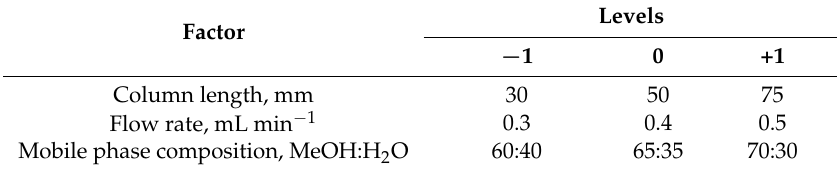
Table 2. Conditions design of experiments (DoE) approach to development of an UHPLC